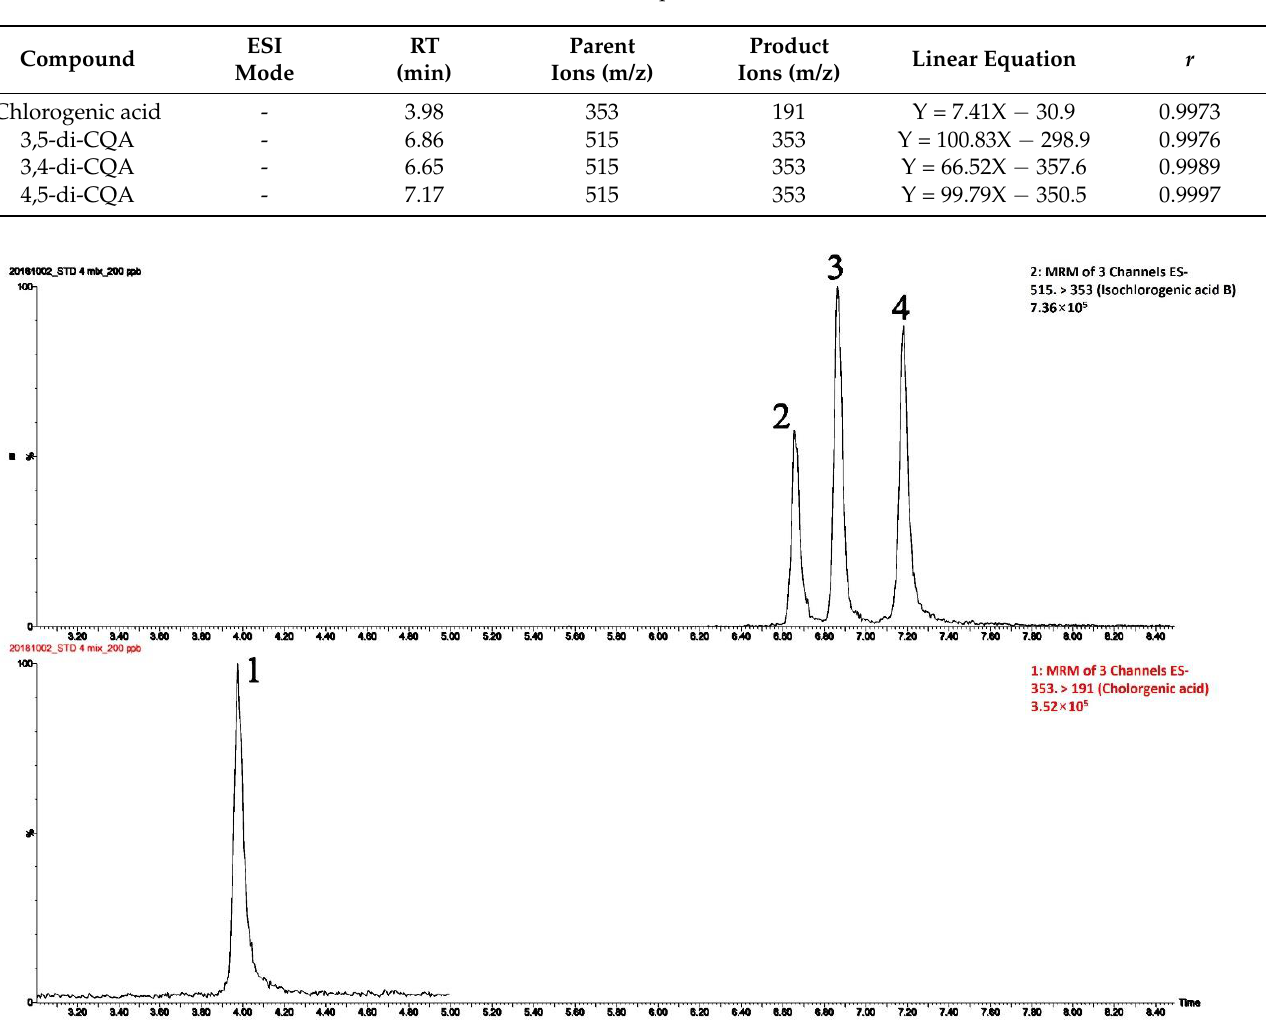
Table 1. Retention time (RT), parent ions, product ions, linear equation (5~200 ng mL − 1 ), and correlation coefficient ( r ) of each compound standard.